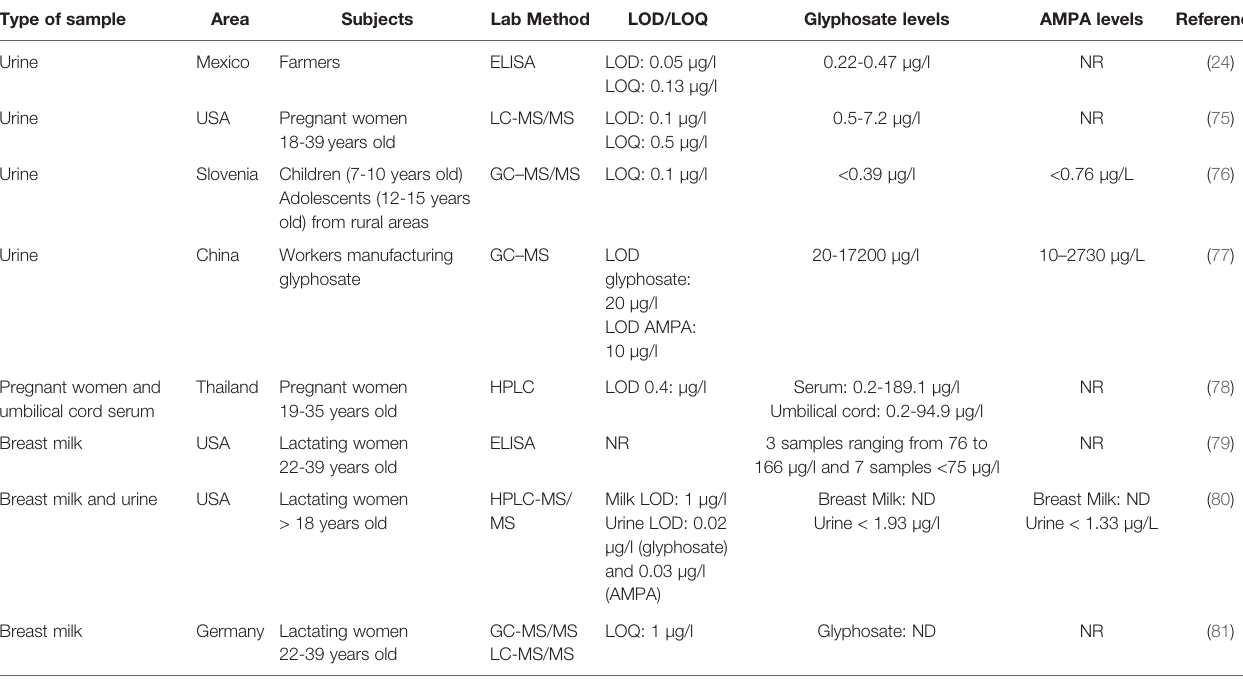
TABLE 2 | Glyphosate and AMPA concentrations in human biological